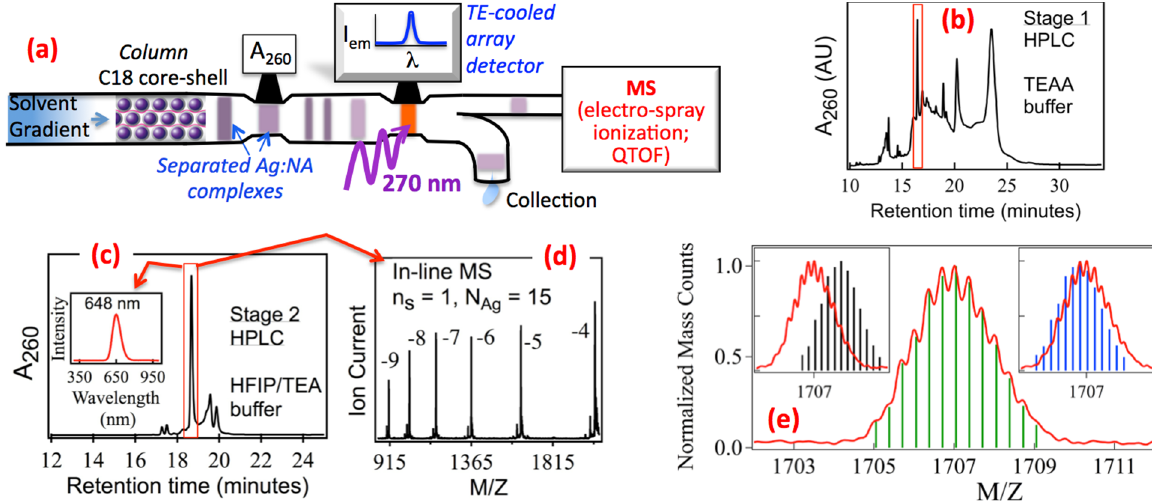
Figure 2. ( a ) Schematic of the HPLC-mass spectrometry (MS) system used to determine composition and optical properties of pure Ag N -DNA [14,28]; ( b ) Absorbance chromatogram, A 260 , from the 1st stage of purification by HPLC, with TEAA/TEA buffer, shows multiple peaks corresponding to many different Ag-bearing DNA species in the as-synthesized solution. The boxed peak is for the red fluorescent Ag N -DNA; ( c ) A 260 chromatogram for the 2nd HPLC stage, with HFIP/TEA buffer, which separates out remaining impurities. This enables inline MS ( d ) to identify the red emitter as an Ag 15 -DNA containing just one DNA strand ( n s = 1); ( e ) We separately identify M and Z by resolving the isotope peak envelope in high resolution MS. Alignment of measured (red) and calculated isotope patterns (bars) determines the total ( N ), neutral ( N 0 ) and cationic ( N + ) Ag content in Ag N -DNA, where the total Ag content N = N 0 + N + . (Adapted with permission from references